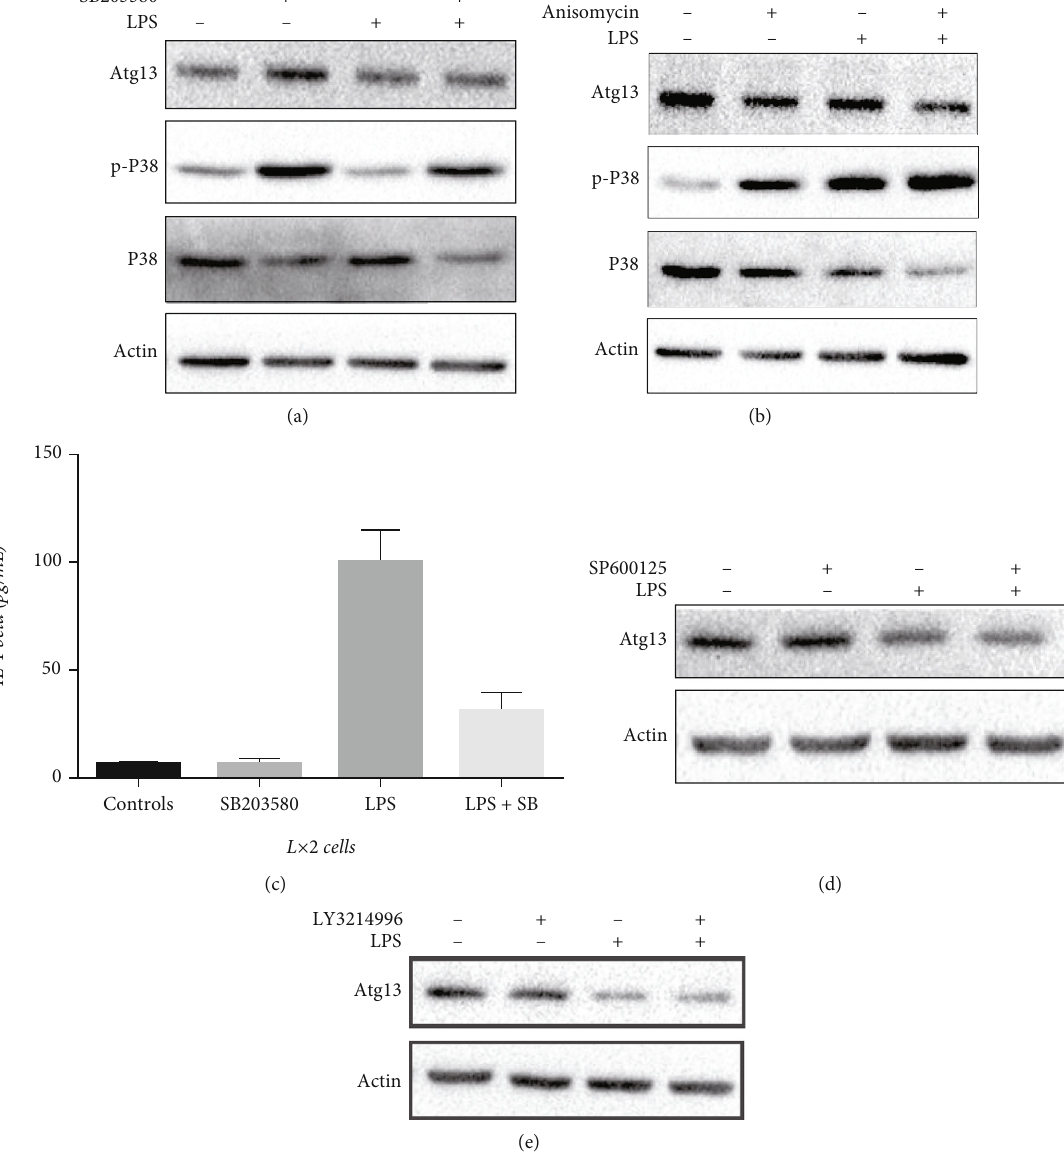
Figure 7: LPS promotes in fl ammation and induces Atg13 loss via p38 MAPK. (a, b) SB203580 (5 μ M) alleviated while Anisomycin (10 μ M) promoted LPS (1 μ g/mL, 4h)-induced decrease of Atg13 (e, f). (c) SB203580 (5 μ M) alleviated LPS (1 μ g/mL, 4 h)-induced IL-1 β secretion. (d, e) Neither SP600125 (40 μ M) nor LY3214996 (5 nM) altered expression of